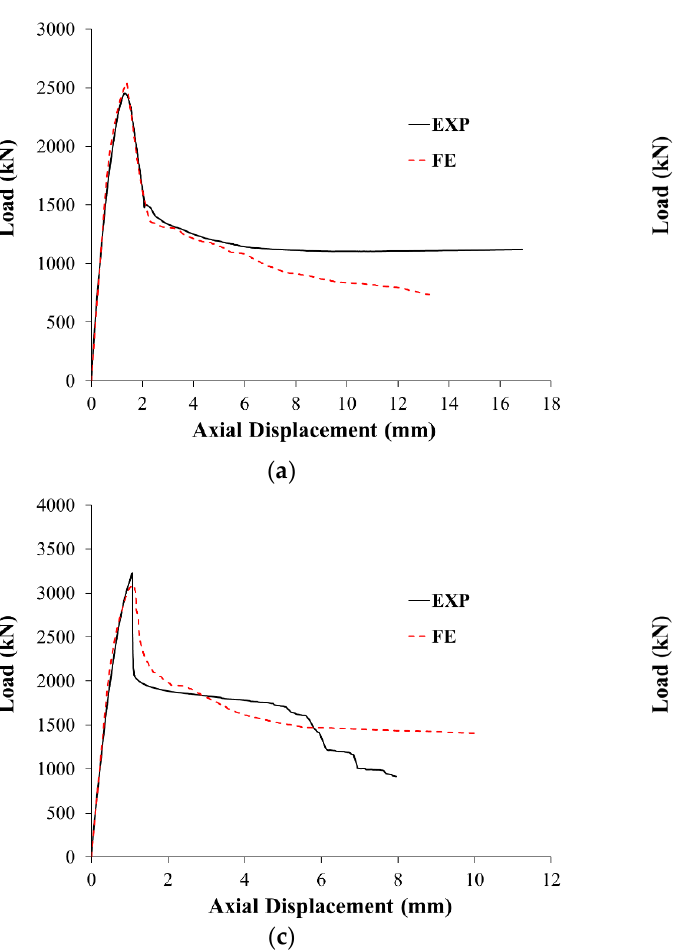
Figure 20. Experimental versus FE load-displacement curves for strengthened specimens: ( a ) SW1;